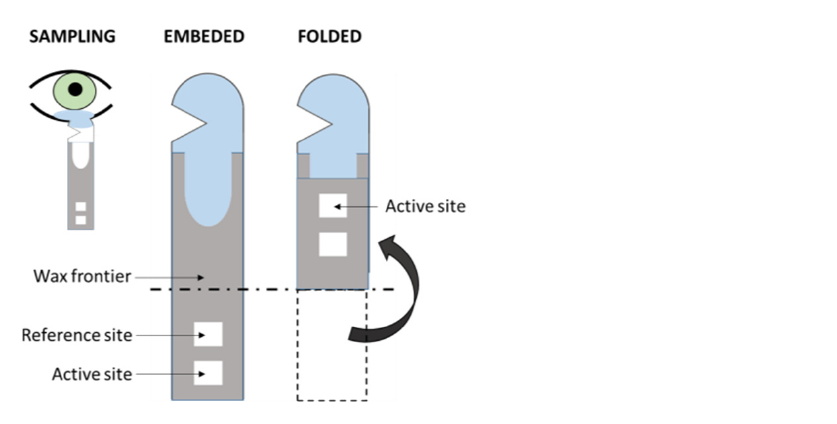
Figure 5. Scheme of the folding Schirmer strip sensor described in Kang et al. [130]